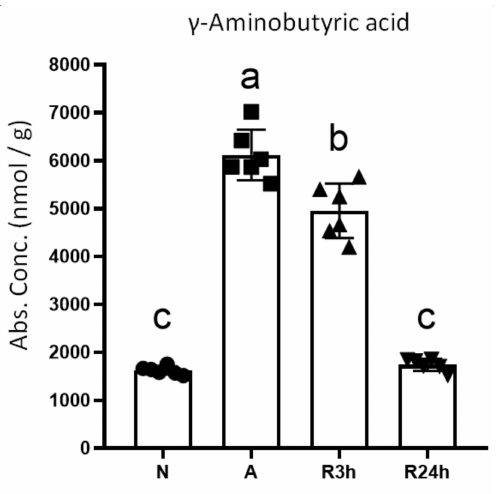
Figure A2. γ -aminobutyric acid from brain tissue. Graphs of absolute concentrations for γ - aminobutyric acid (GABA) of brain. N, normoxia (control); A, anoxia; R3h, 3 h reoxygenation; R24h, 24 h reoxygenation. Different letters indicate statistical differences between groups calculated using one-way ANOVA with Tukey’s post-hoc ( p -value ≤ 0.05). Data are presented as means ± S.D. Values as reported by HMT.